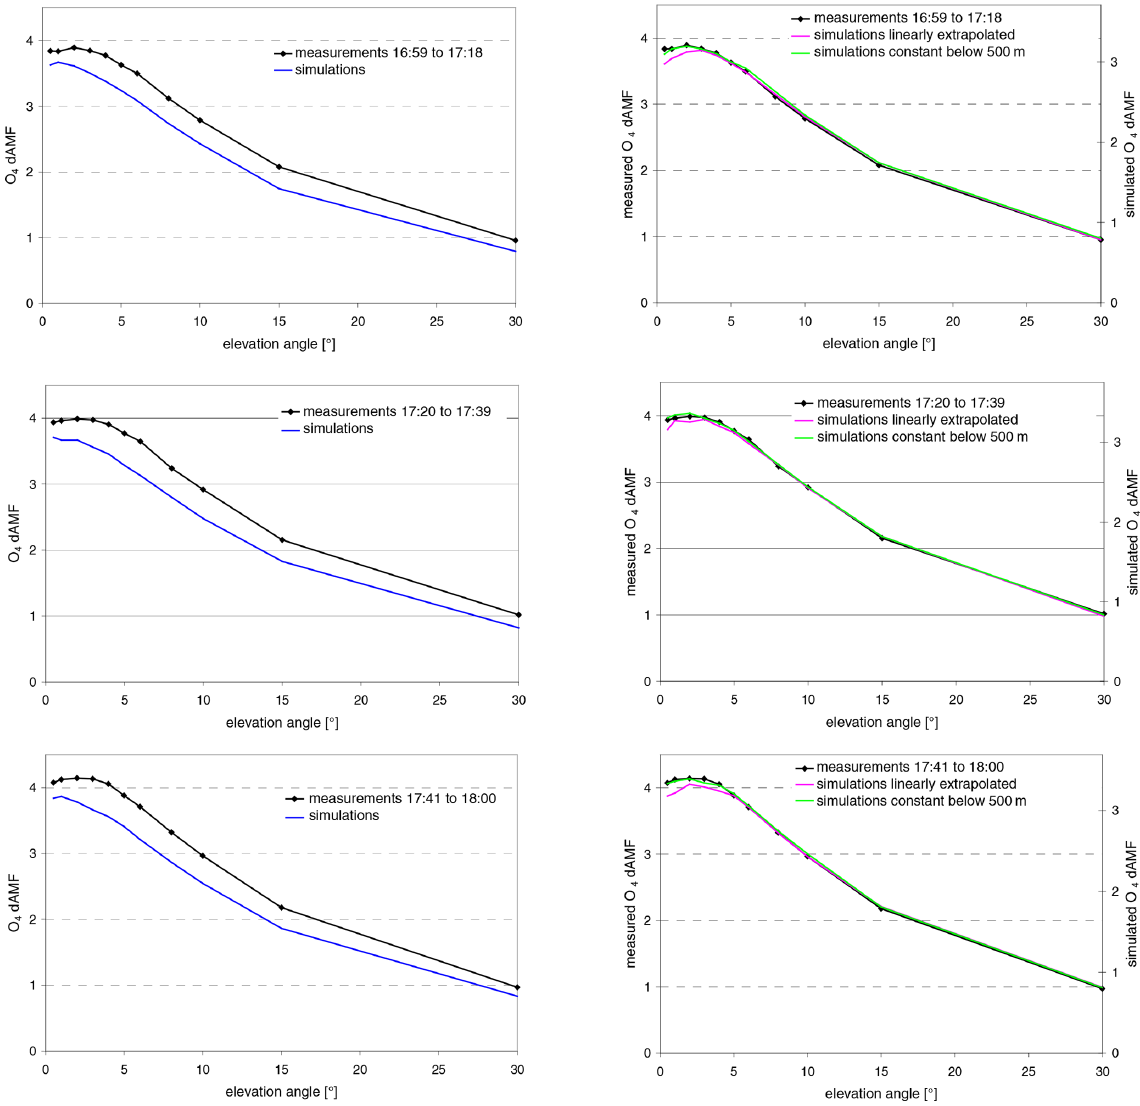
Figure 6. Comparison of the measured and simulated O 4 dAMFs for selected elevation sequences without cloud contamination. On the left side, the measured O 4 dAMFs are compared to simulations for a pure Rayleigh atmosphere. On the right side, they are compared to simulation results including aerosols (two profiles with either constant or linearly extrapolated aerosol extinction below 500m). Note that in the right part, separate y axes on the right sides are used for the simulation results. The maxima of the right y axes are chosen to achieve the best agreement between the measured and simulated O 4 dAMFs (see